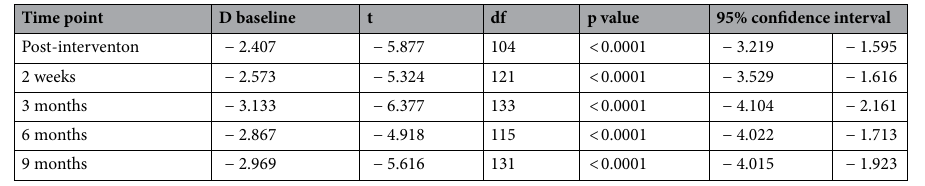
Table 4. Changes in mean binge episode frequency from baseline to all post-intervention time points. T-tests are vs. baseline. Bayes Factors are for between-groups comparisons at post-intervention time points (ANOVA or Mann–Whitney U). Null hypothesis = (no group difference) vs alternative (group means unequal for ANOVA; RIT bingeing < Sham bingeing in Mann–Whitney). Bayes factors > 3 are considered evidence in favour of the